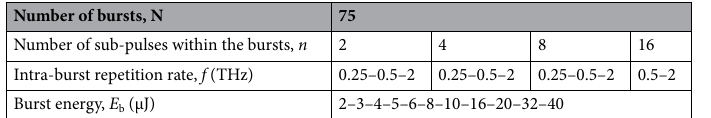
Table 1. Summary of experimental parameters.